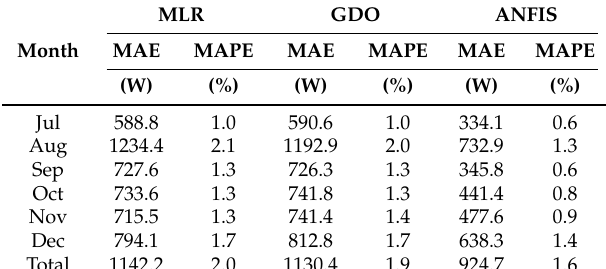
Table 6. Error comparison between MLR, GDO and ANFIS for MCS.